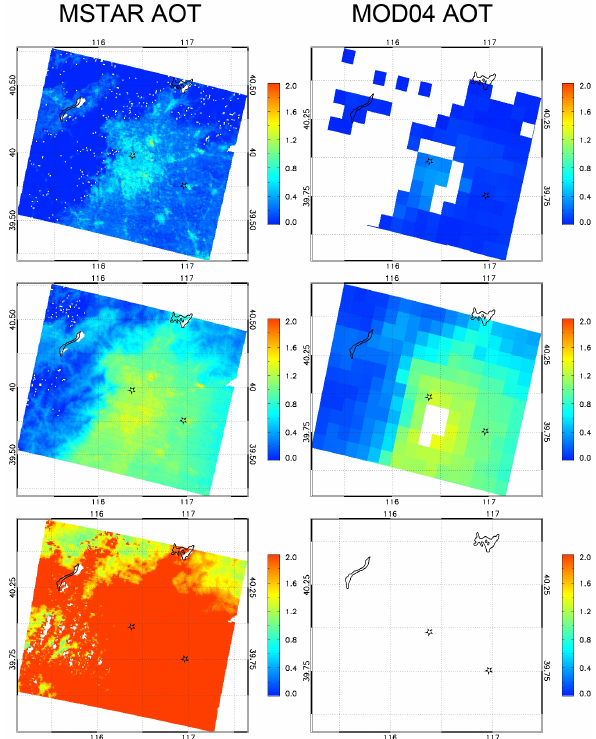
Fig. 11. Case study of clean, polluted, long-range transported dust for an urban area (200 × 100km 2 ). Horizontal and vertical axes are longitude (degrees east) and latitude (degrees north). Note that MOD04 for the dust case cannot retrieve AOT because of the high reflection by dust